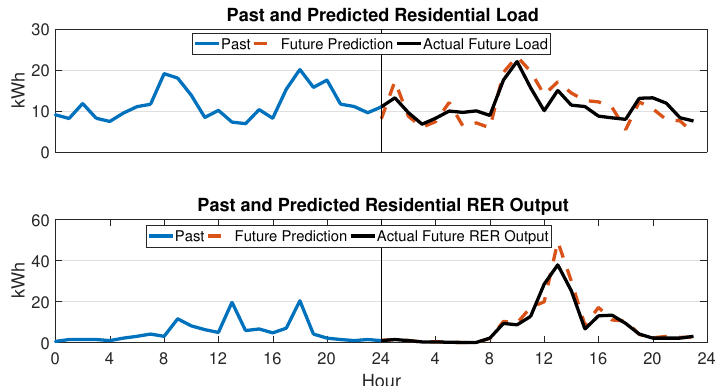
Figure 3. Two days of residential demand and supply profiles used in simulation.